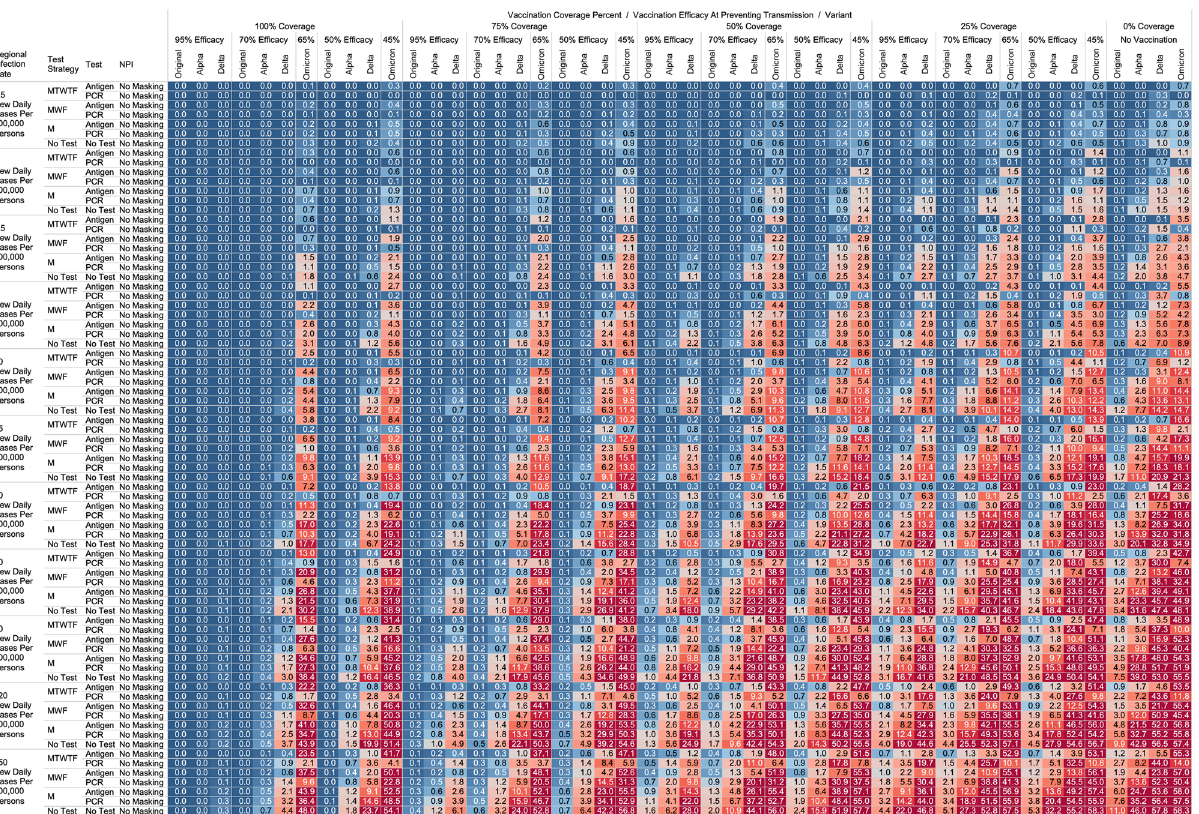
Figure 1. Heatmap of simulated workplace-acquired infections through 480 person weeks with testing performed in all workplace members and with no masking intervention. The sensitivities of PCR and antigen tests a variant specific as outlined in Table